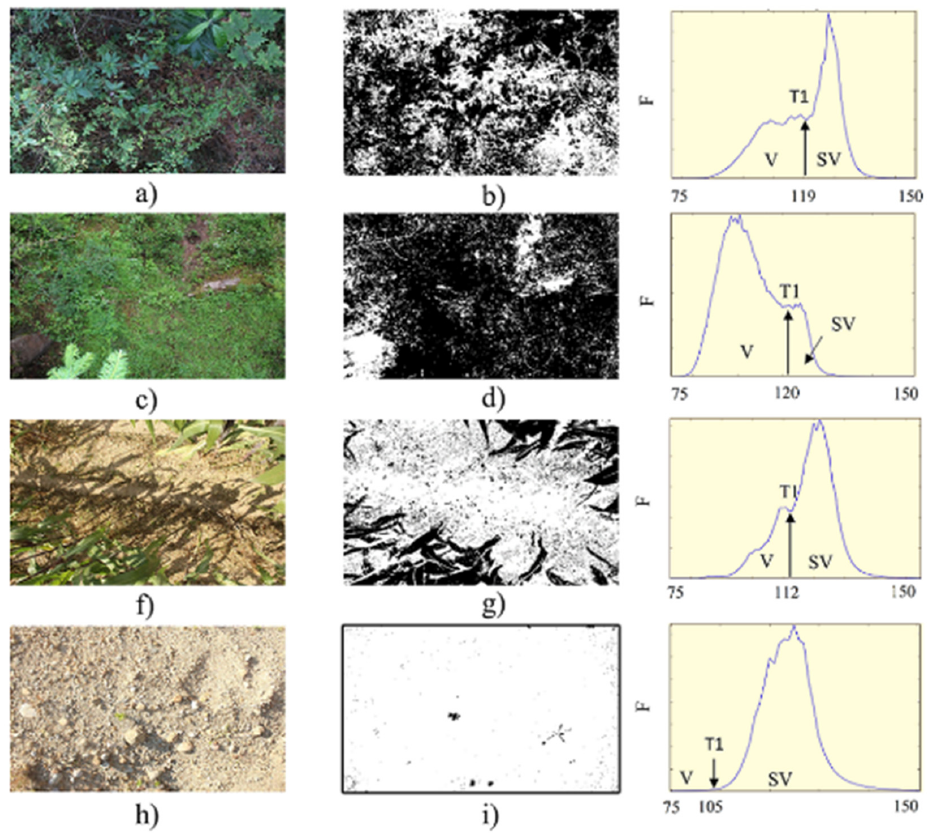
Figure 8. Classification of images in different land uses to nadir. Images ( a , c , f,h ) correspond to the original photograph. Images ( b , d , g , i ) correspond to the classified images. The third column shows the distribution of the histogram according to the cover.